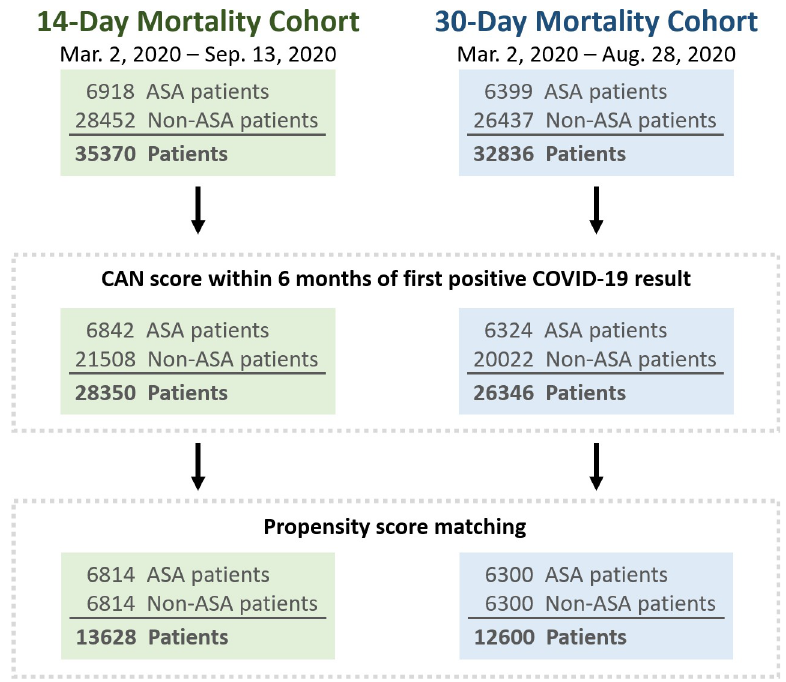
Fig 1. Cohorts for the 14-day and 30-day mortality evaluation of Veterans diagnosed with COVID-19. ASA = Aspirin.